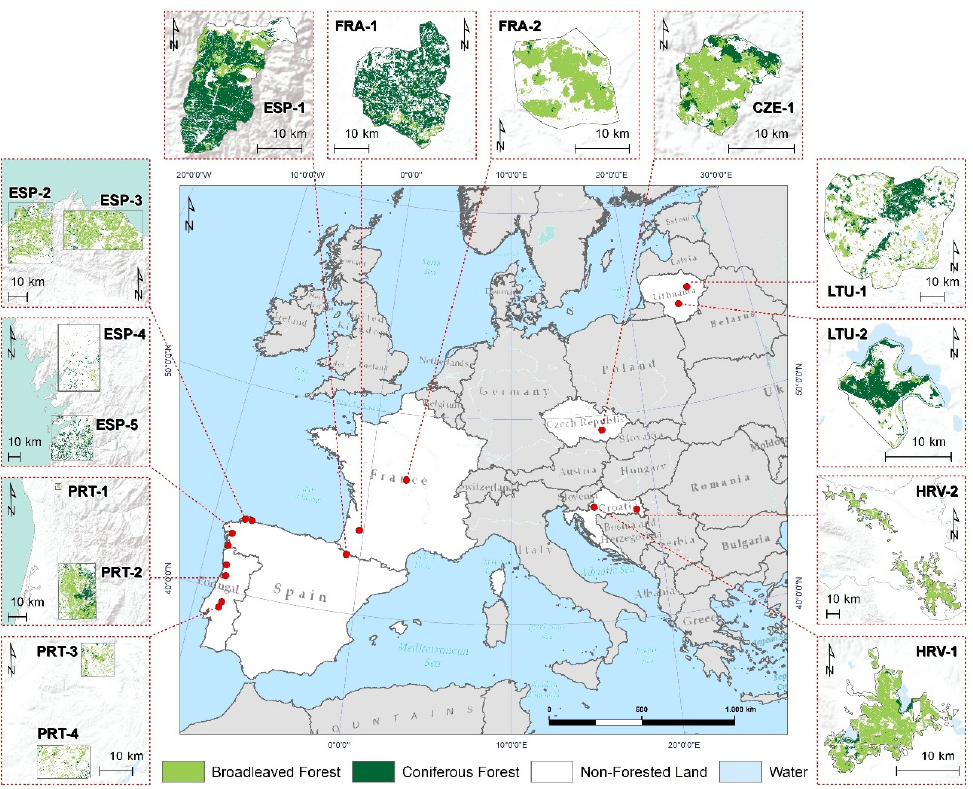
Figure 1. Location of the 16 AOIs across Europe with their abbreviations. The forest type classes showed are taken from the Joint Research Centre Forest Type Map (2006) [20,37].